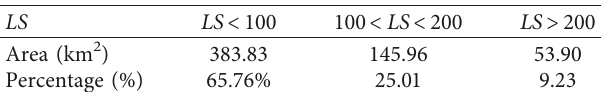
Table 3: The area and percentage of calculated LS -factor in the